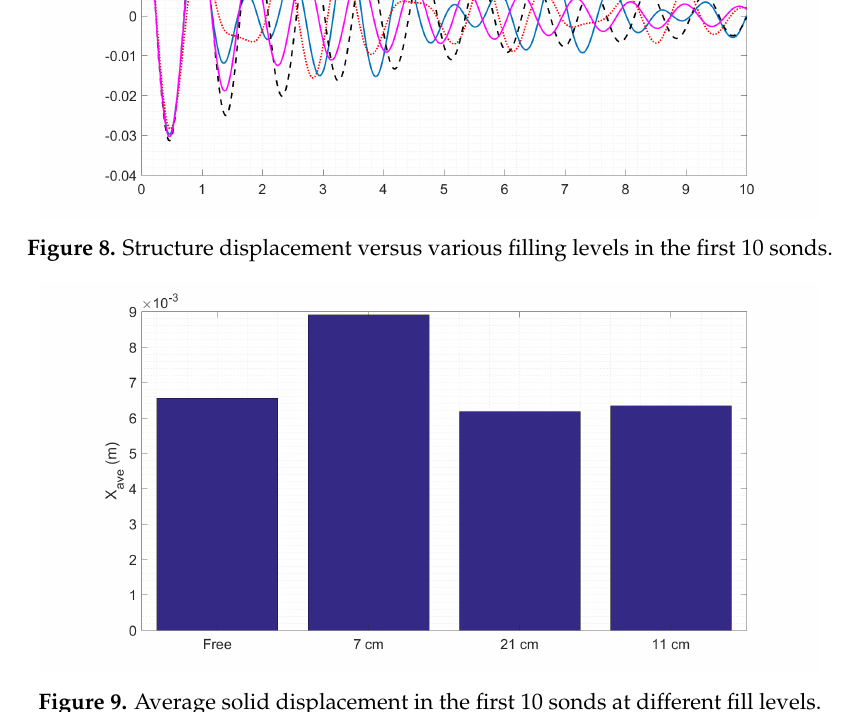
Figure 9. Average solid displacement in the first 10 sonds at different fill